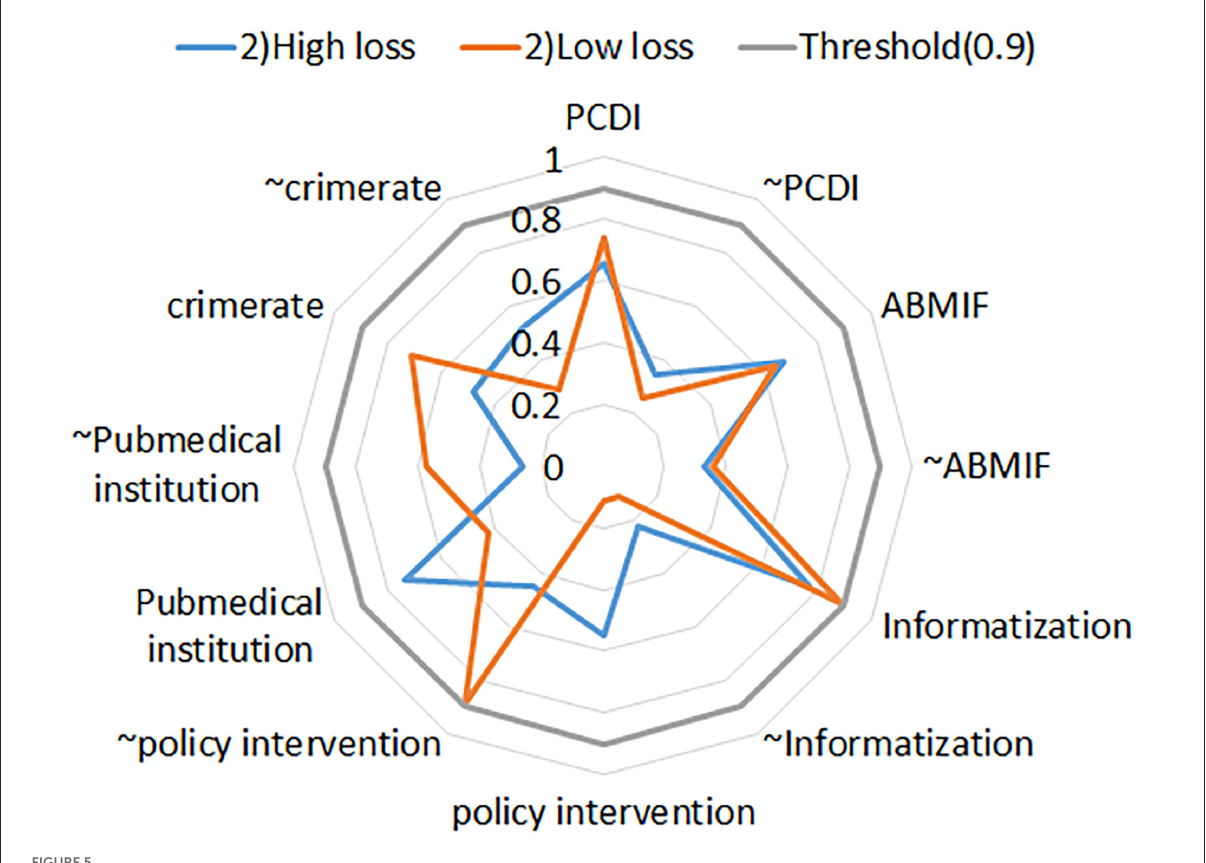
FIGURE5 Necessity analysis of conditions in model 2.